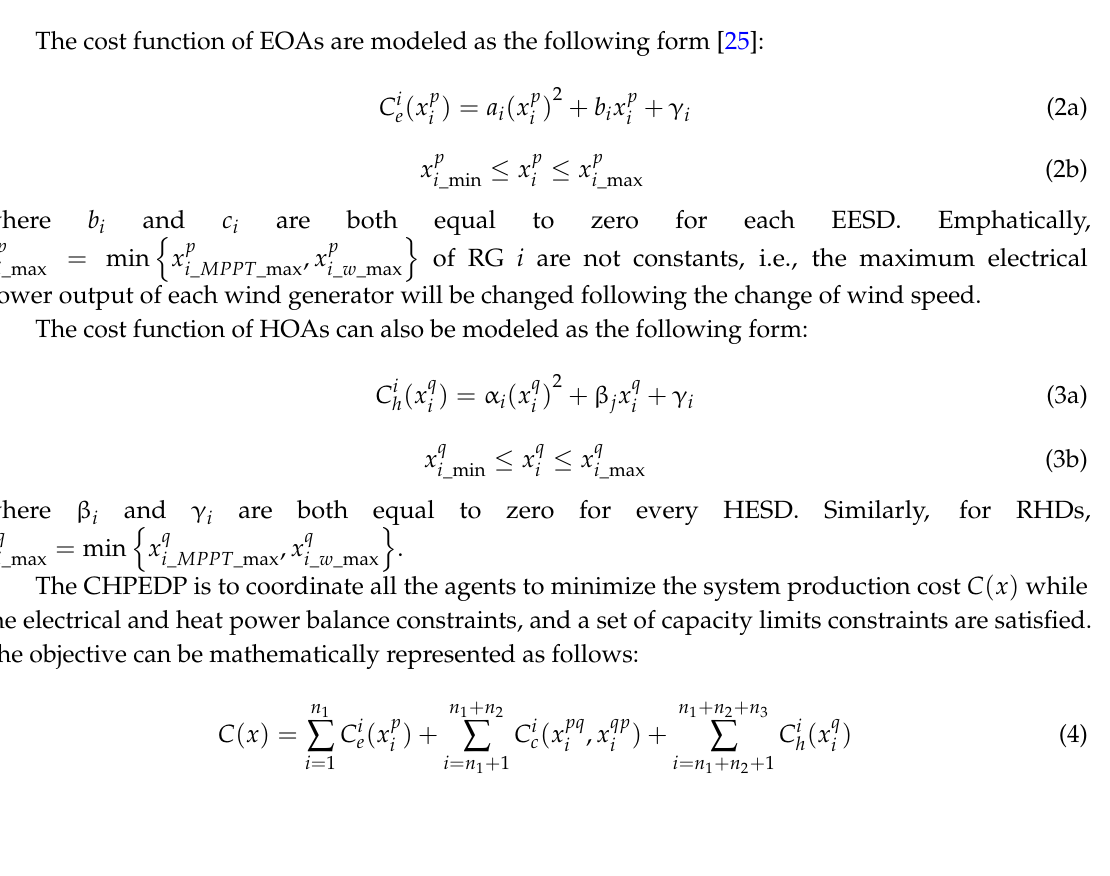
Figure 2. Feasible operating region of co ‐ generation agents (CGA).